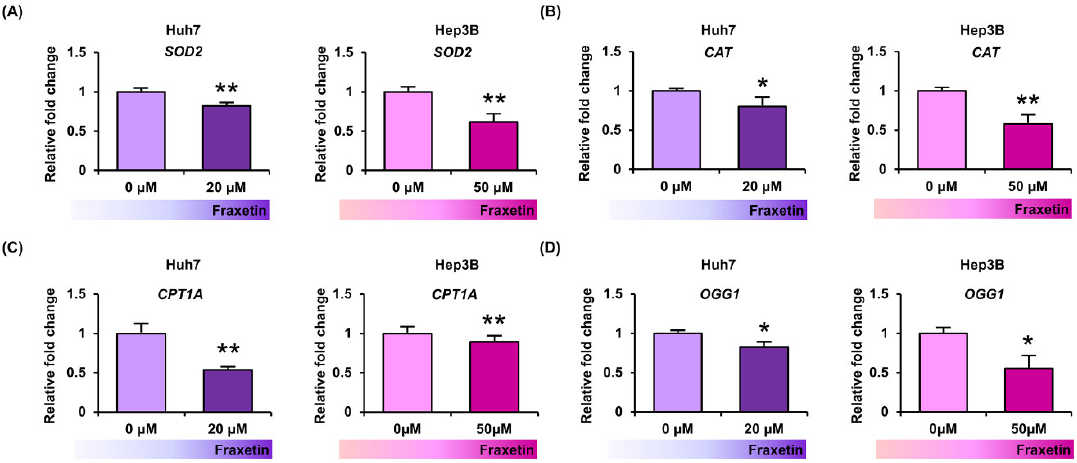
Figure 4. Effects of fraxetin on oxidative stress-related gene expression. ( A – D ) Quantitative analysis of mRNA levels of SOD2 ( A ), CAT ( B ), CPT1A ( C ), and OGG1 ( D ) normalized relatively to the house-keeping gene GADPH. RNA was extracted after fraxetin treatment (20 μM or 50 μM) for 24 h on Huh7 and Hep3B cells. Asterisks indicate the significance levels of comparisons between vehicle- and fraxetin-treated cells (* p < 0.05 and ** p < 0.01).